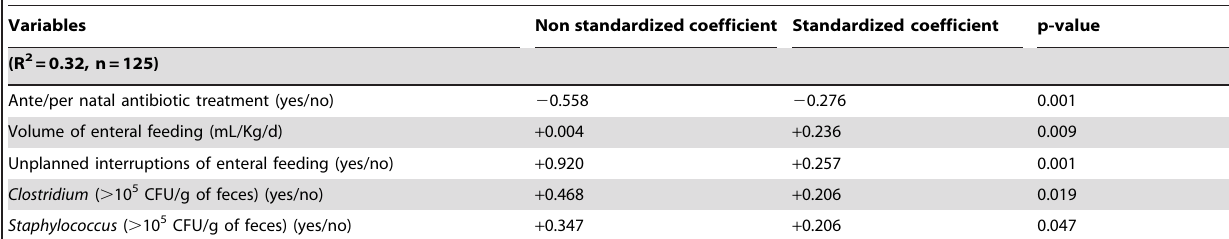
Table 2. Main explanatory variables found by multivariate analysis for fecal calprotectin values.